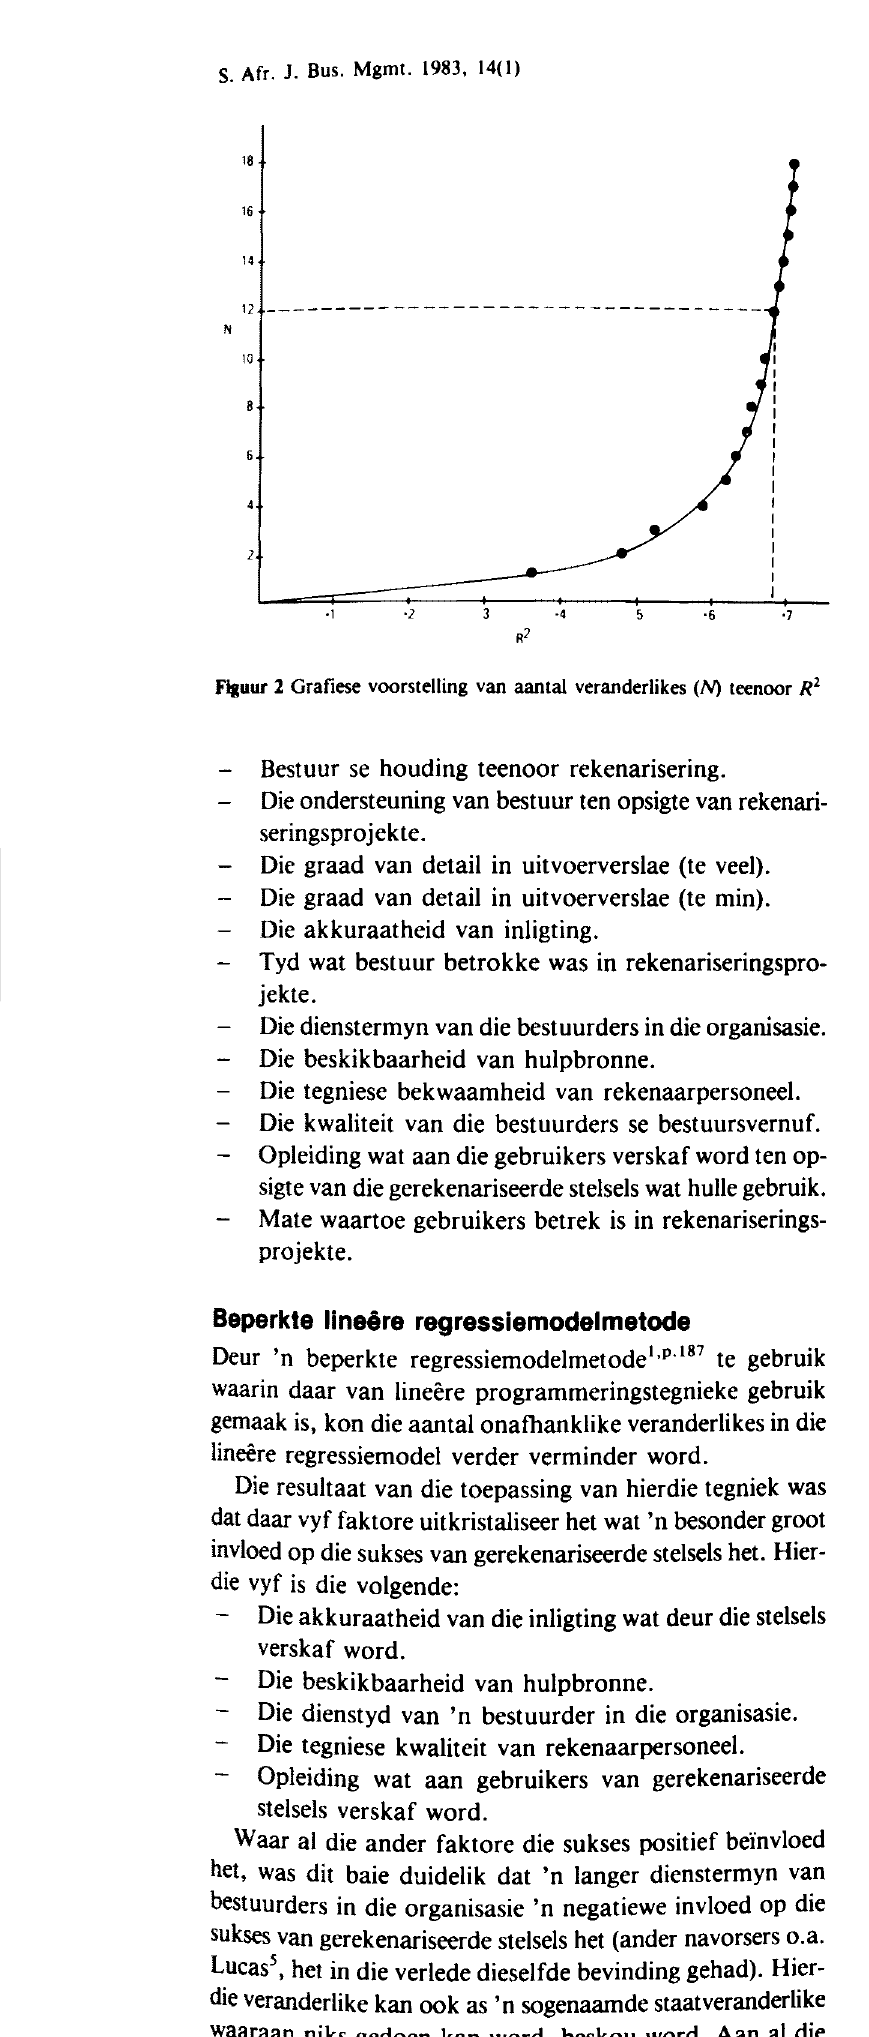
Bestuur se houding teenoor